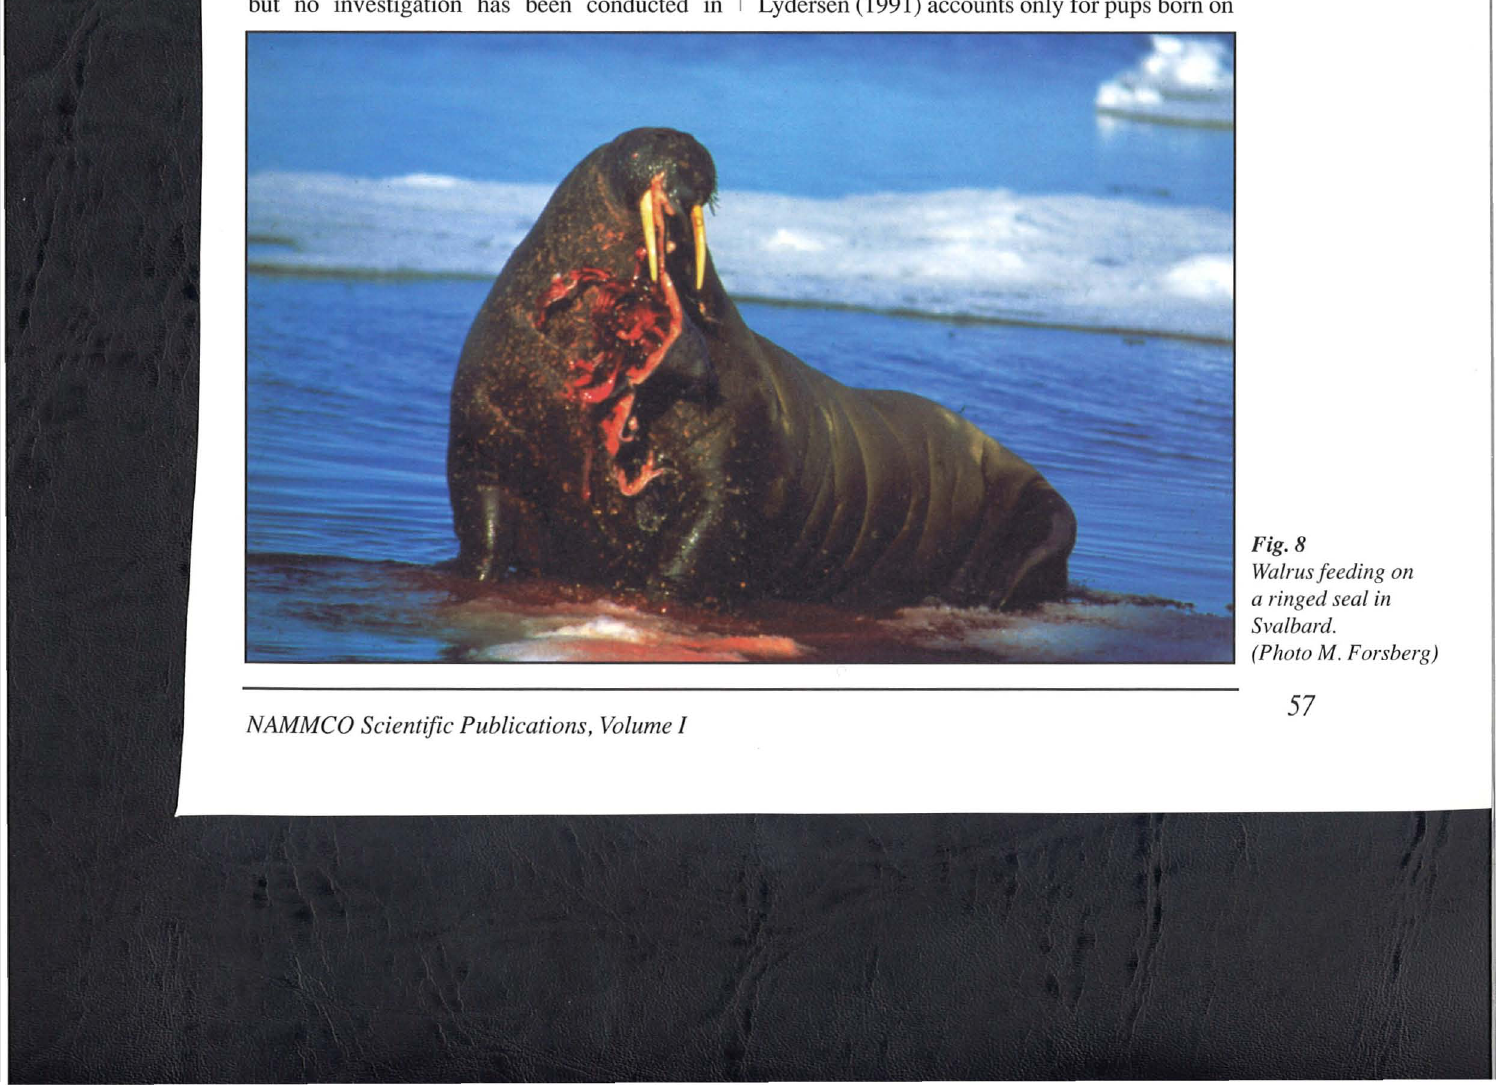
Fig. 8 Watrusfeeding on a ringed seal in Svalbard. (Photo M.